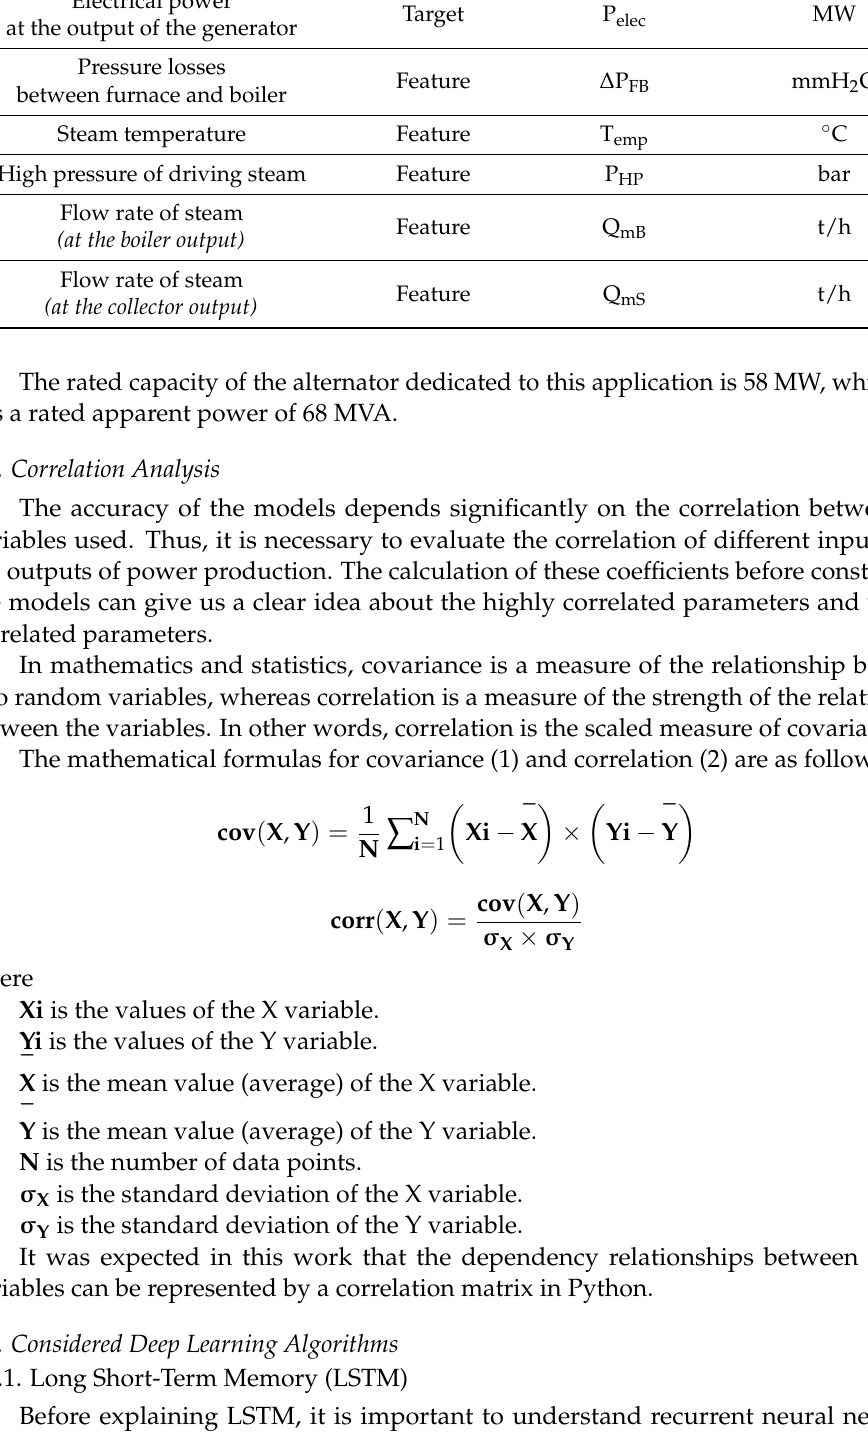
Table 2. Main feature parameters that influenced the variation in power in the studied power plant. Mathematical Physical Parameter Category Symbol Measuring Unit Electrical power Target P elec MW at the output of the generator Pressure losses Feature ∆ P FB mmH 2 O between furnace and boiler Steam temperature Feature T emp ◦ C High pressure of driving steam Feature P HP bar Flow rate of steam Feature Q mB t/h (at the boiler output) Flow rate of steam Feature Q mS (at the collector output)